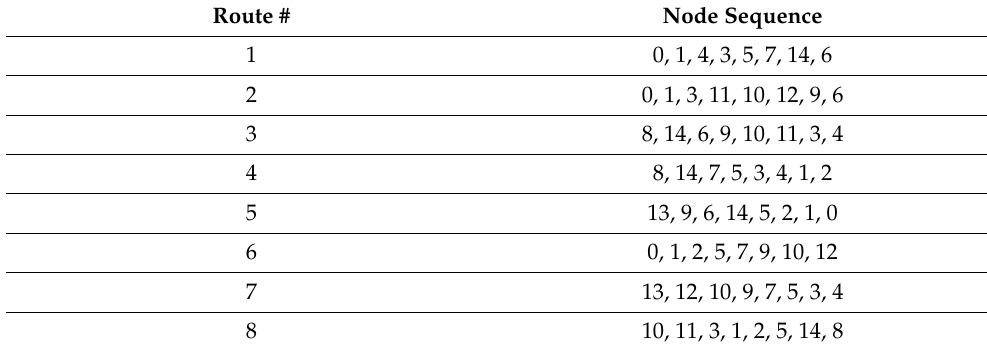
Table 8. Best Route Set for 8-Route Case.